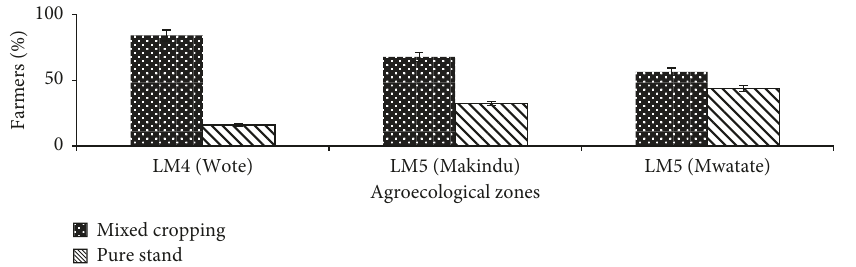
Figure 4: Percentage of farmers growing cowpea on pure stand and by mixed cropping in various agroecological zones in Makueni and Taita Taveta during the 2016 short rains. Table 2: Percentage of farmers and the corresponding production levels during the 2015 short rains and 2016 long rains in various agroecological zones in Makueni and Taita